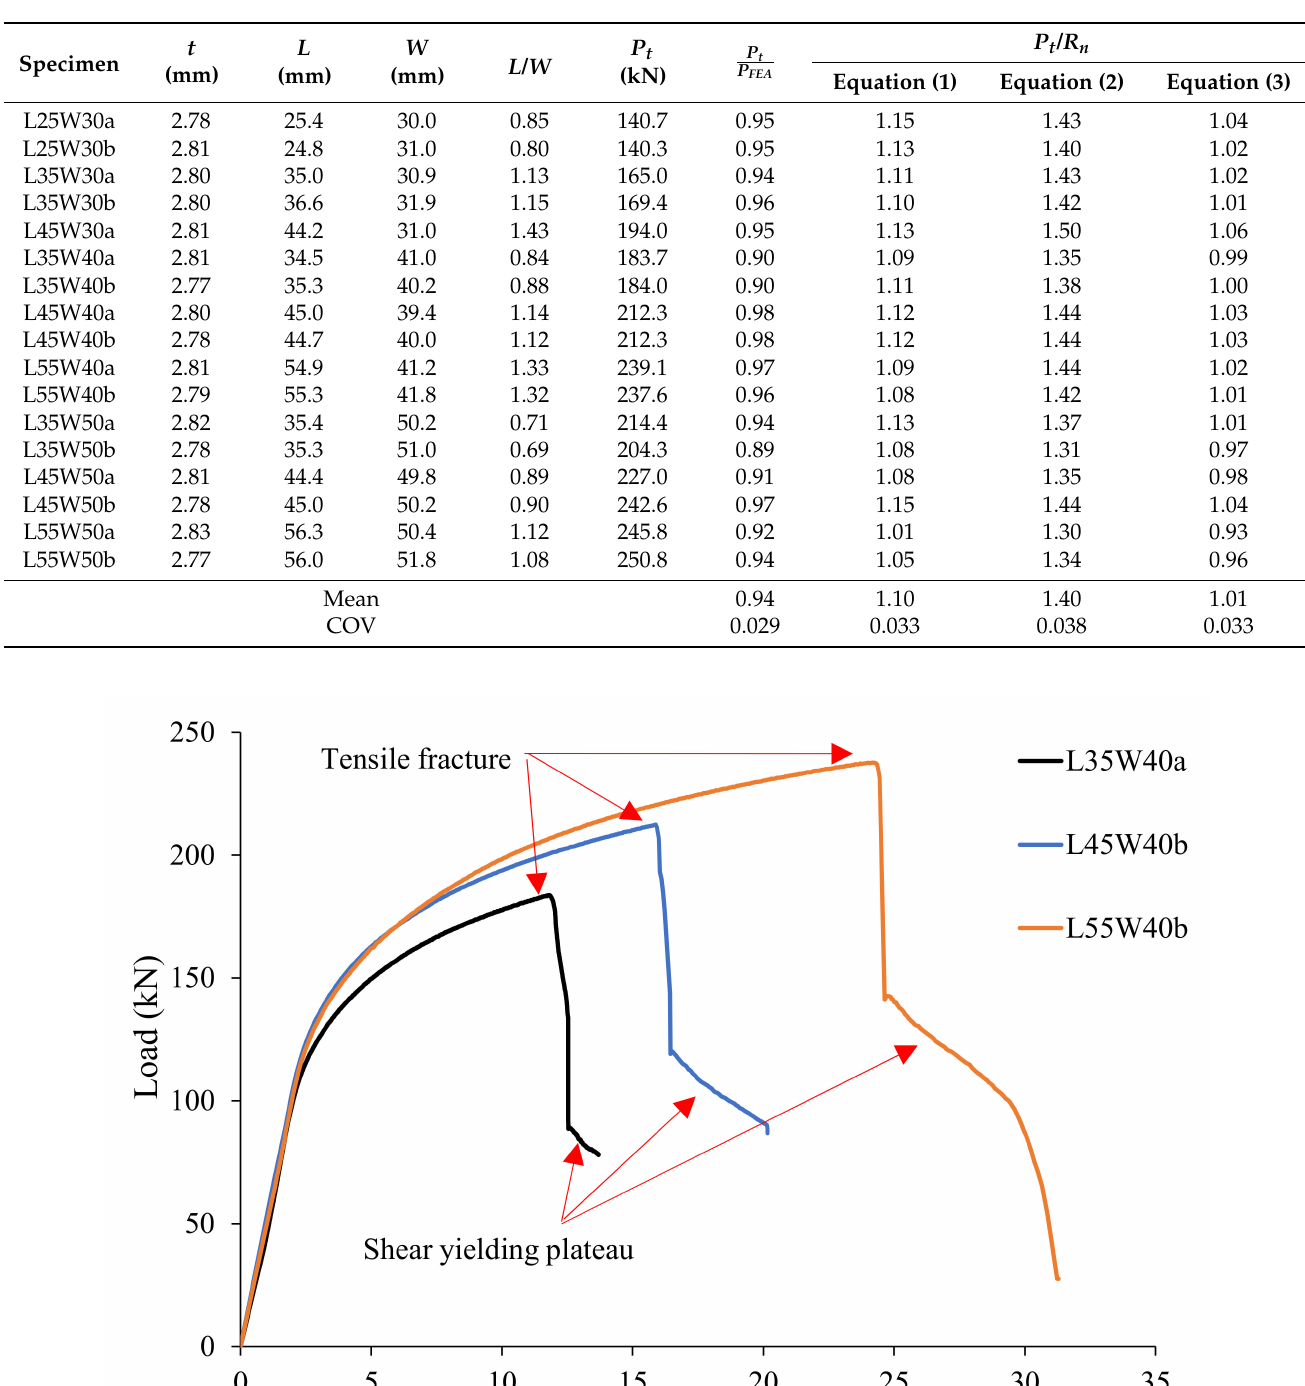
Table 2. Test results of welded connections.